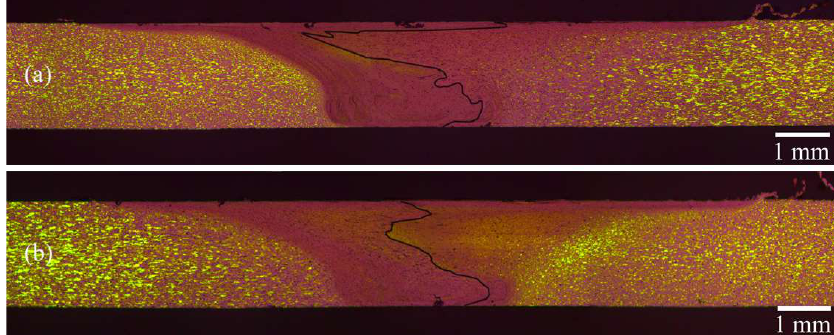
Figure 6. Cross sections of ( a ) FSW-WS = 5-AA7050-R and ( b ) FSW-WS = 5-AA2024-R.